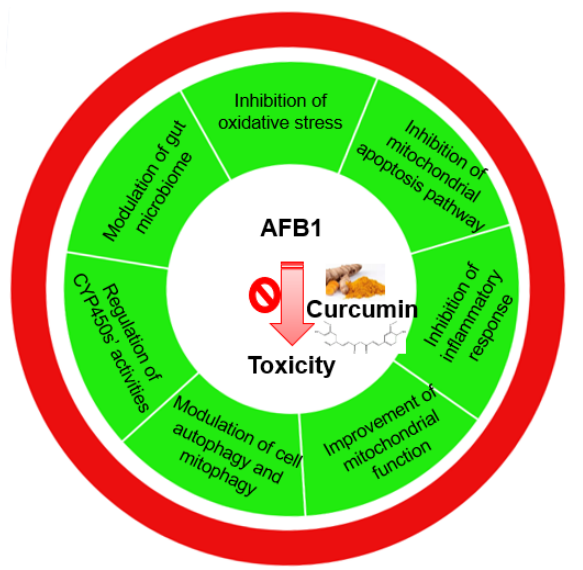
Figure 7. The main actional mechanisms of curcumin protection against AFB1 toxicity.